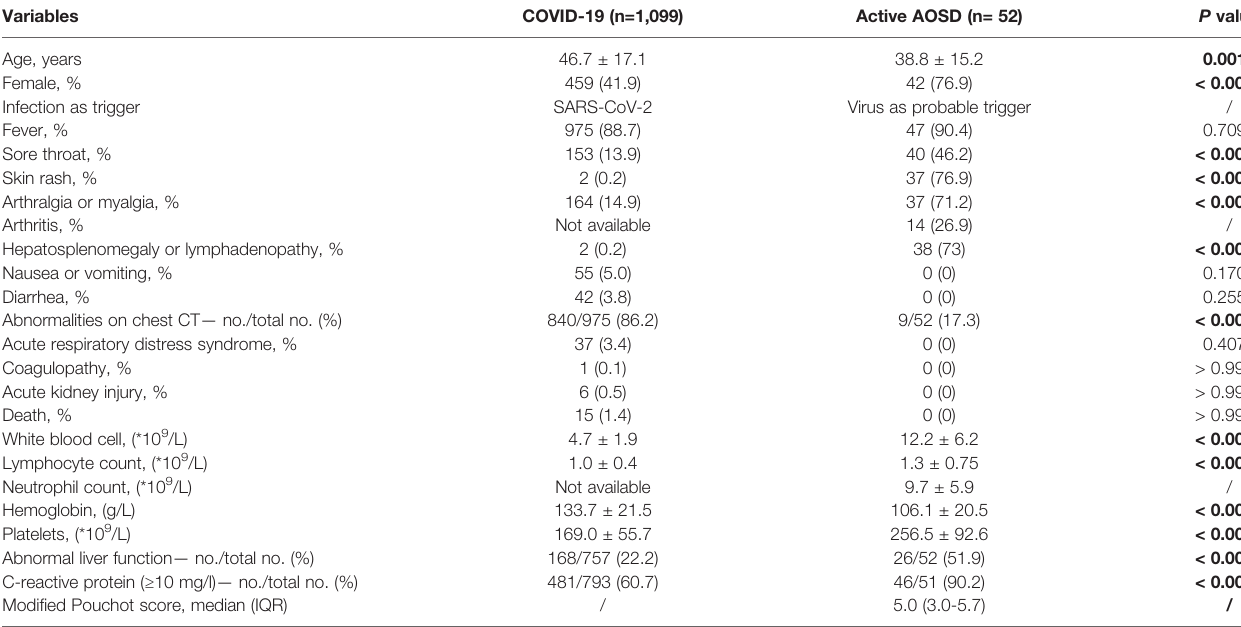
TABLE 2 | Comparison of clinical manifestations and laboratory parameters between COVID-19 and active AOSD.